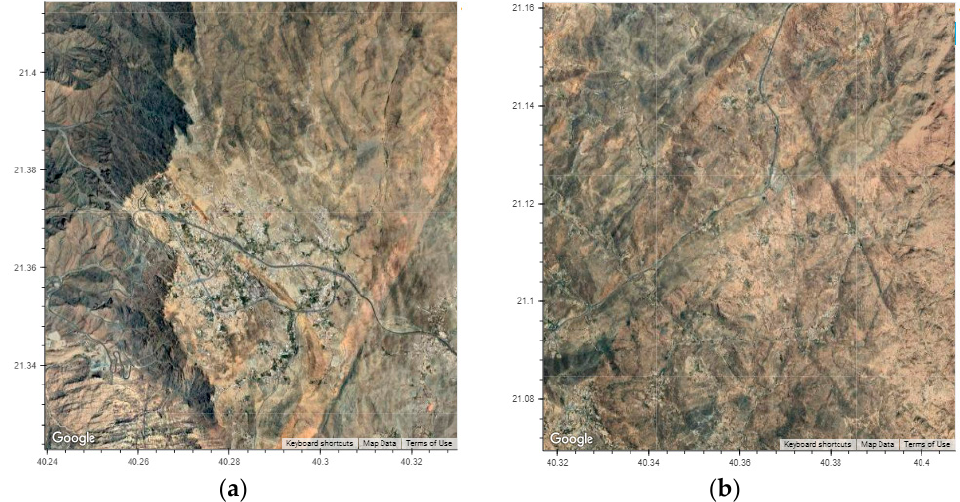
Figure 1. Geographical locations of the 10 Taif rose farms (Al-Hada ( a ) and Al-Shafa ( b )) from which the samples were collected.